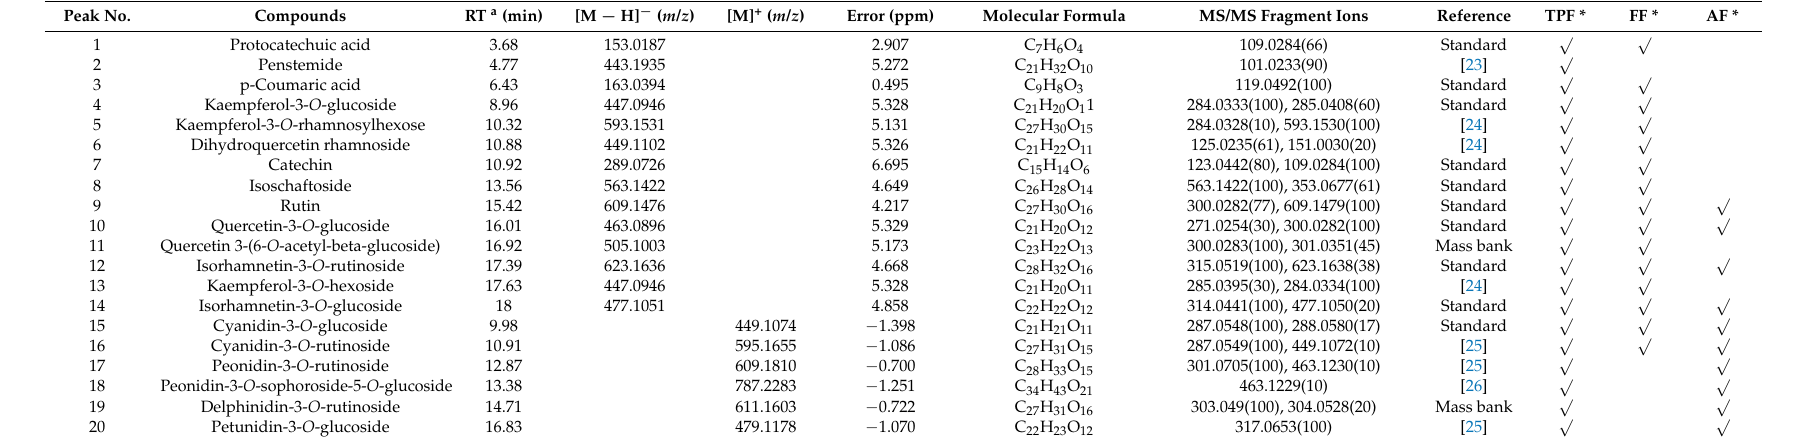
Table 1. Main chemical compounds detected and characterized of the different phenolic fractions of P. utilis fruits using UHPLC-ESI-HRMS/MS in negative/positive